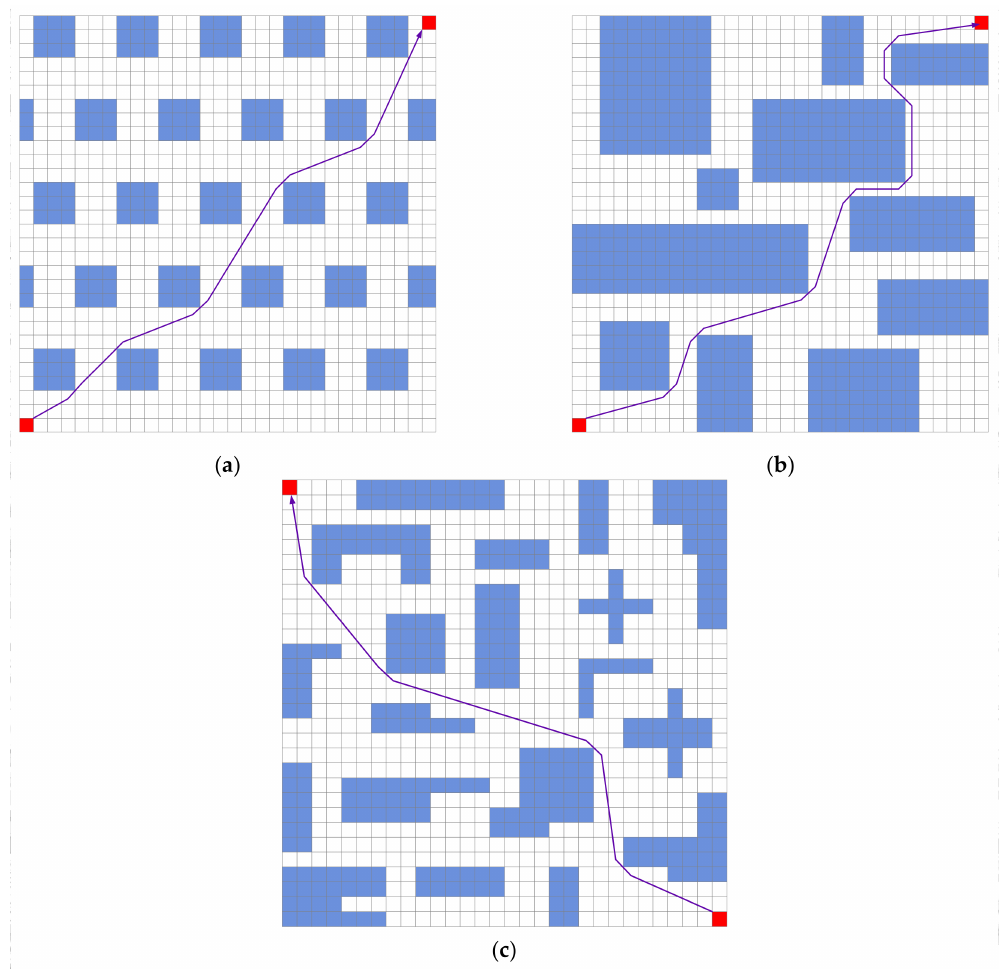
Figure 23. Grid-based representation and collision-free shortest paths in environments. ( a ) Environment 3; ( b ) Environment 4; ( c ) Environment